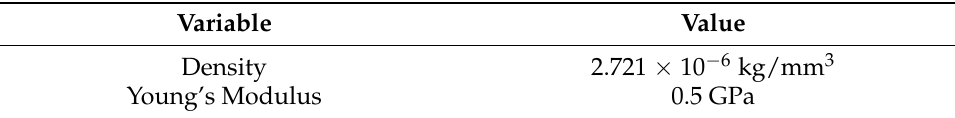
Figure 14. Multicell Lattice Structure Configuration: ( a ) Configuration #1. ( b ) Configuration #2. ( c ) Configuration #3. Table 11. Jellyroll Material Properties